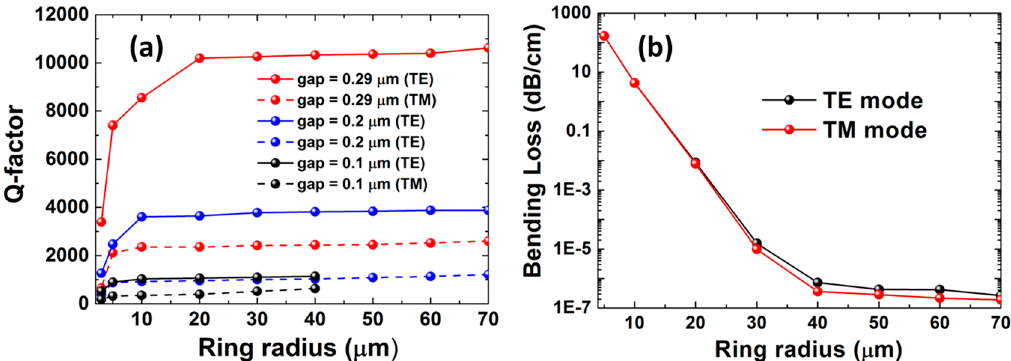
Figure 5. ( a ) Q ‐ factor of microring resonator as different ring radii for different gap sizes, ( b ) Bending loss variation as bending radius. The modes were calculated at λ = around 1.55 μ m.